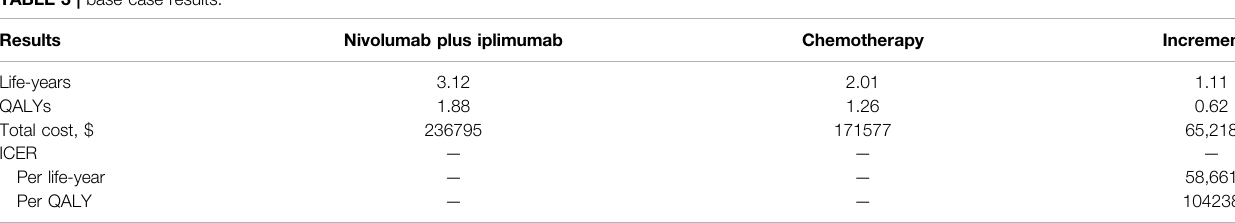
TABLE 3 | base case